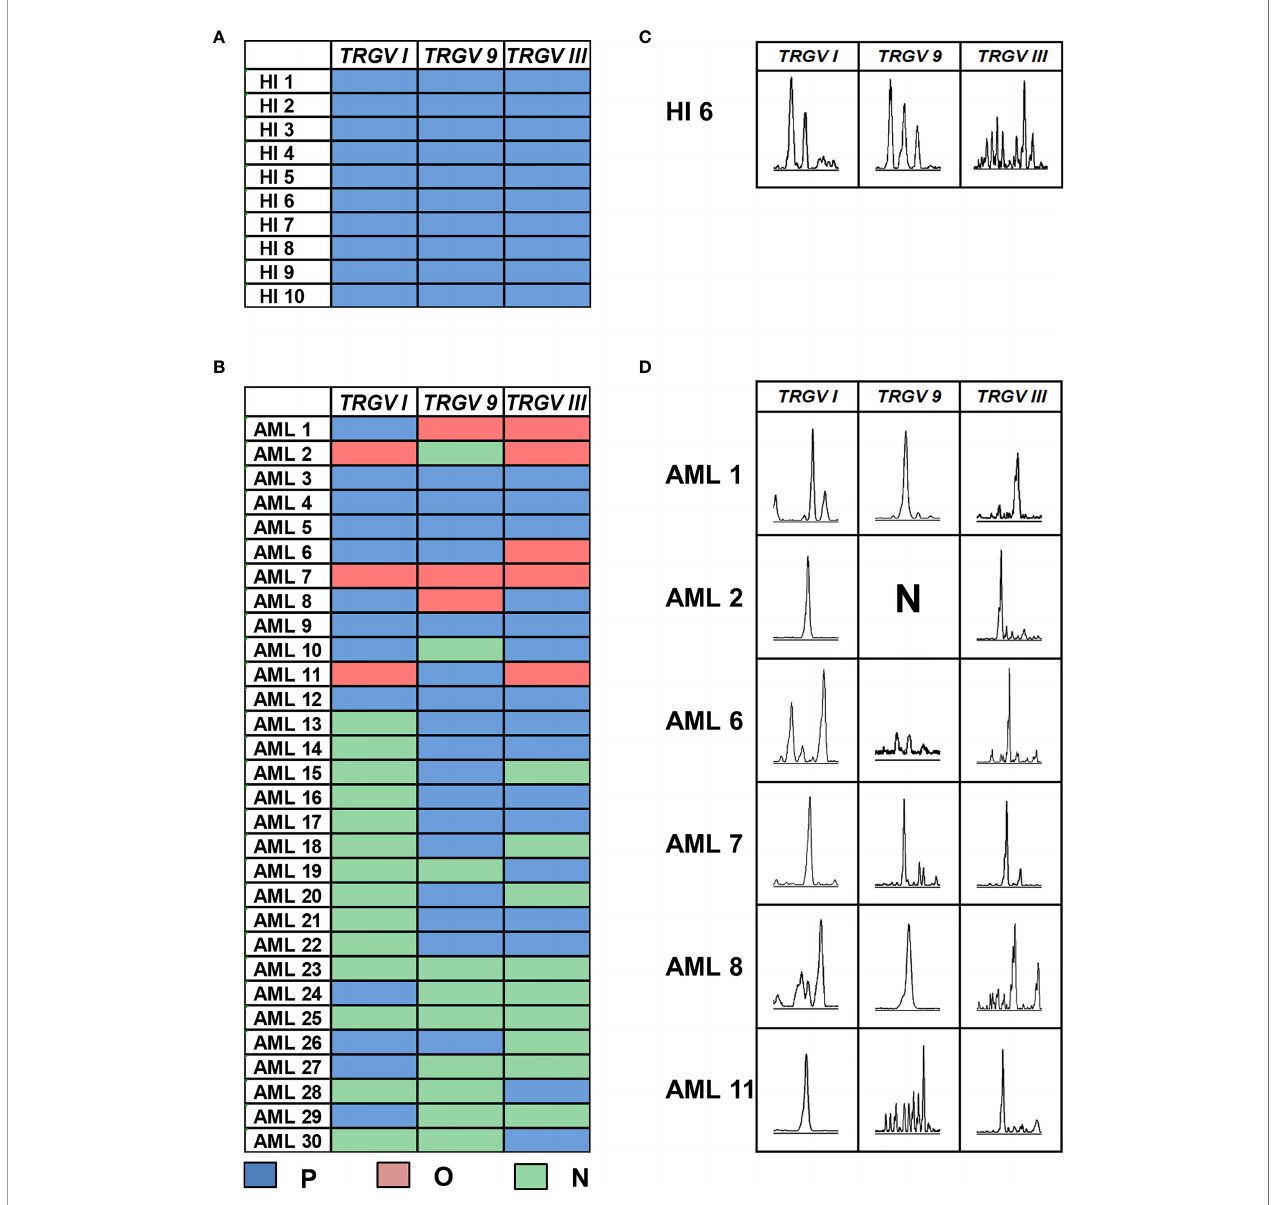
FIGURE 1 | Distribution and clonality of TRGV subfamilies in gd T cells from 10 healthy individuals and 30 patients with AML. The feature of distribution and clonality of TRGV subfamilies in healthy individuals and patients with AML (A, B) . Expression pattern of TRGV subfamilies in one case of healthy individual and six AML patients (C, D) . P, polyclonality; O, oligoclonality; N,